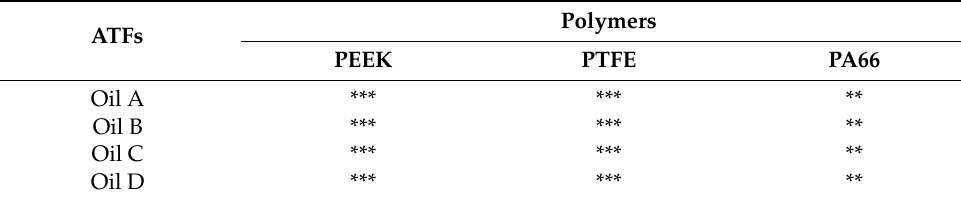
** Medium compatibility; *** High